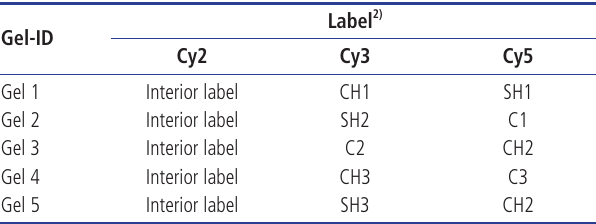
Table 1. The design of fluorescence-labeled samples